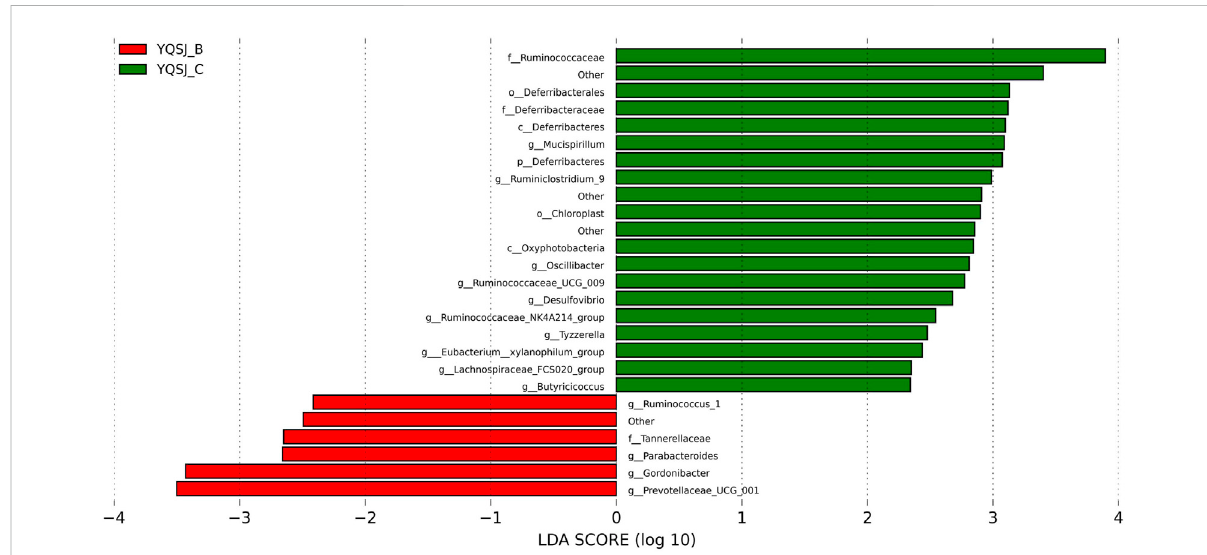
FIGURE 4 The LDA score in LEfSe analysis of bacterial community structure in YQSJ group. The distinct color represented the different stages in YQSJ group. The red color (YQSJ_B) indicated the mouse fecal samples were collected before treatment at day 27 – 28 in YQSJ group, while the green color(YQSJ_C)representedthemousefecalsampleswerecollectedaftertreatmentatday66 – 67(theendpoint)group.The “ other ” representedthe fl ora that was not classi fi ed. The taxa were displayed (|LDA| >